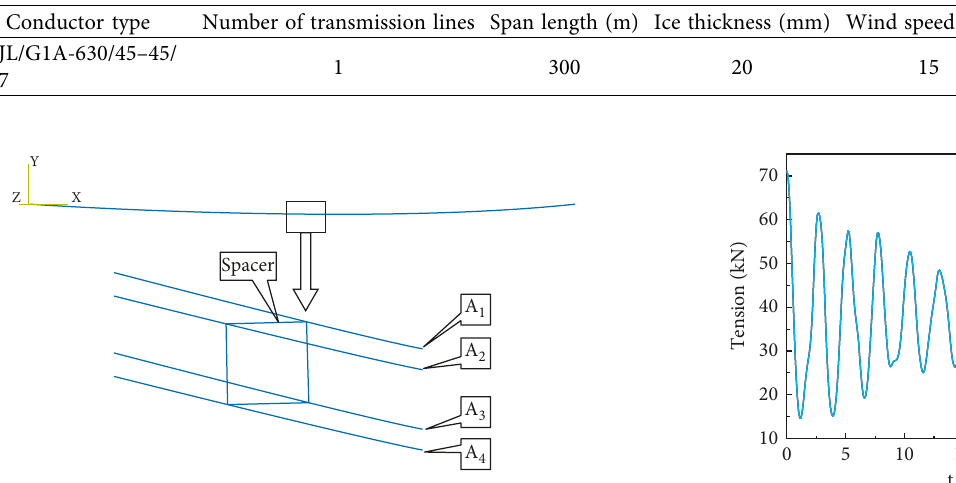
Figure 5: Finite element model of quad bundle conductors with single-span.